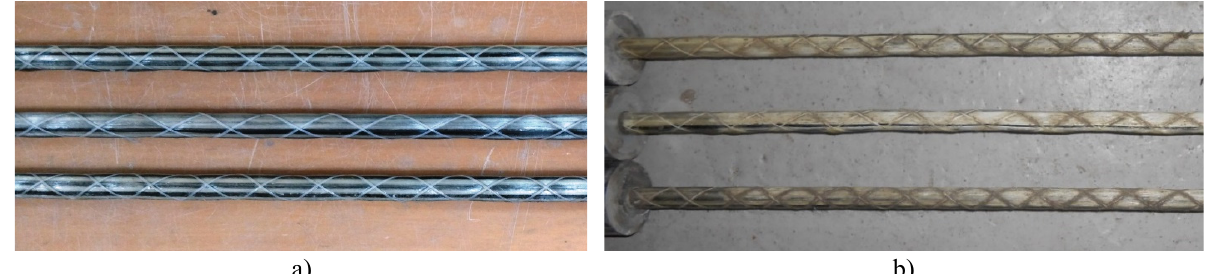
Figure 3. Appearance of ACC K samples before (a) and after (b) exposure in an alkaline −